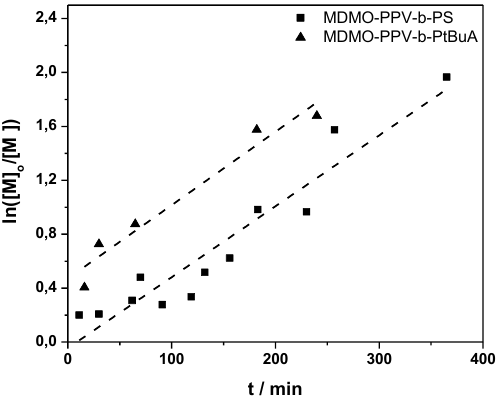
Figure 5 . Semi-logarithmic first order kinetic plot of MDMO-PPV- b -P t BuA and MDMO-PPV- b -PS block copolymerizations via